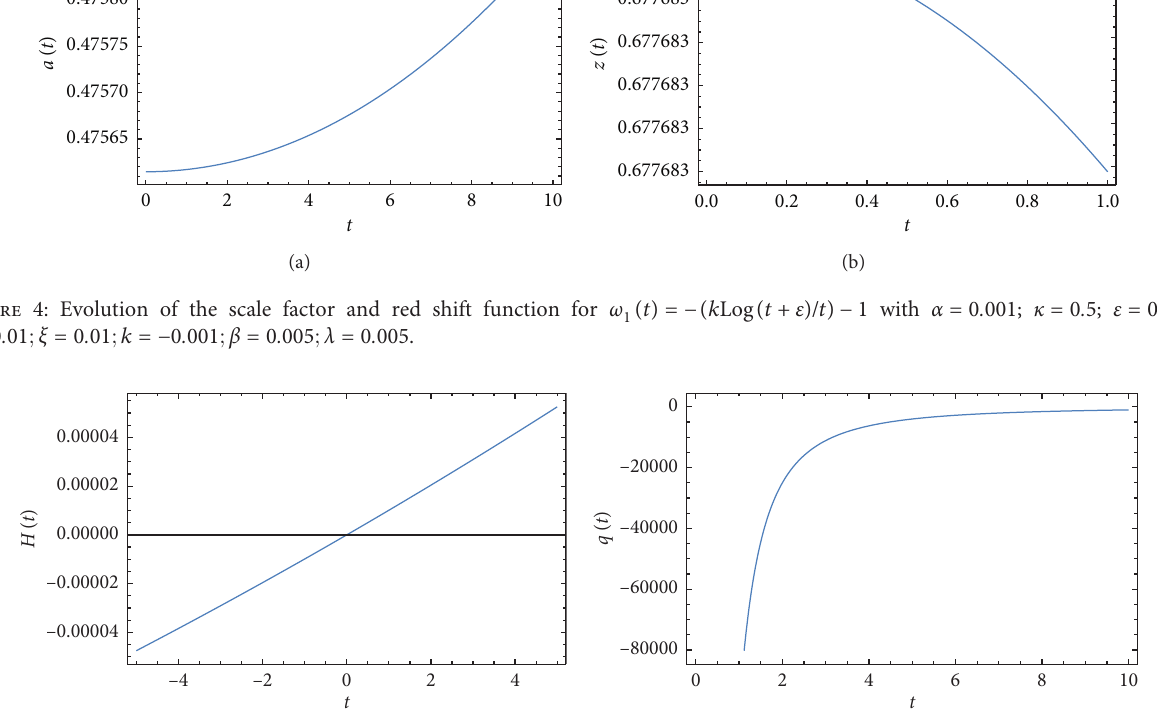
( t ) � − ( k Log ( t + ε ) / t ) − 1 with α � 0 . 001; κ � 0 . 5; ε � 0 . 001; 1